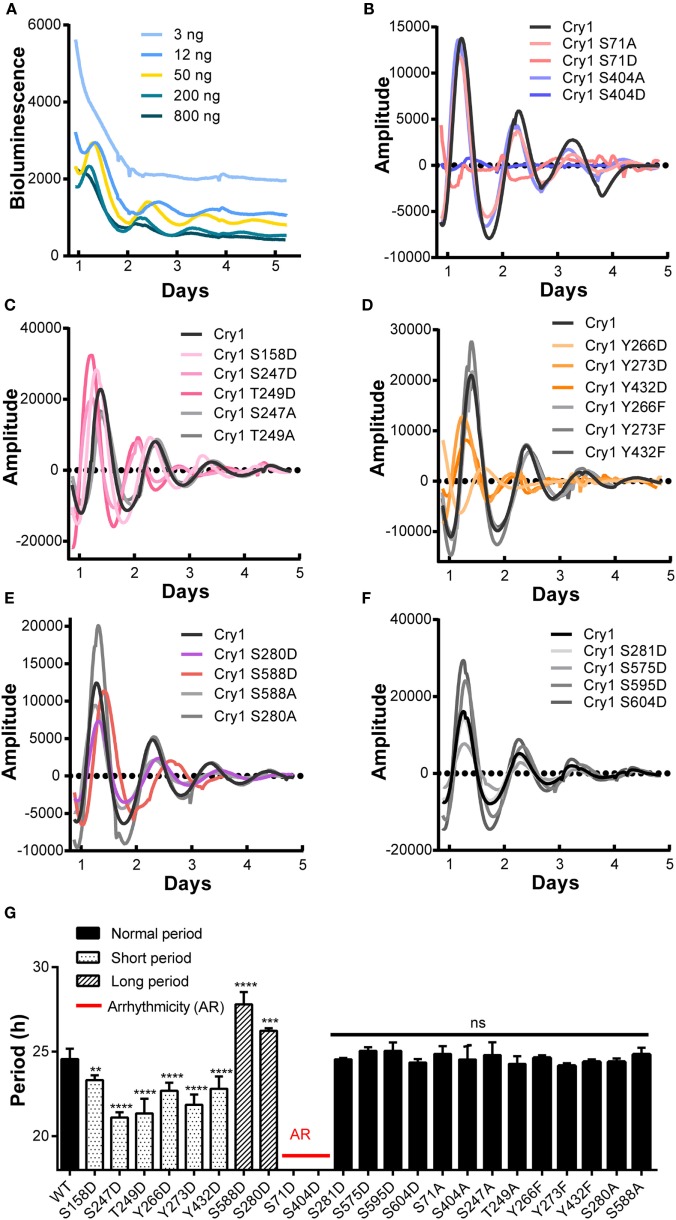
A cell-based screen to identify critical phosphorylation residues on mCRY1 through rescuing rhythmicity in Cry1−/−:Cry2−/− fibroblasts (DKO cells). (A) Dosage-dependent rescue of circadian rhythms in DKO cells by mCRY1. The mCRY1 expression vector was cotransfected into cells with the P(Per2)-dLuc reporter vector. Three days after transfection, the cells were synchronized by dexamethasone treatment and then moved to luciferin-containing medium for 5–6 days of bioluminescence recording. (B–F) The P(Per2)-dLuc reporter rhythms (baseline subtracted) from DKO cells transfected with WT or mutant mCRY1, as noted in the legend. Experiments were performed as in (A). (G) Quantitation of the period length from WT and mutant mCRY1 transfected cells that showed a distinct period phenotype as noted in the legend. Error bars represent SEM (n ≥ 5, **p < 0.01; ***p < 0.001; ****p < 0.0001, ANOVA).